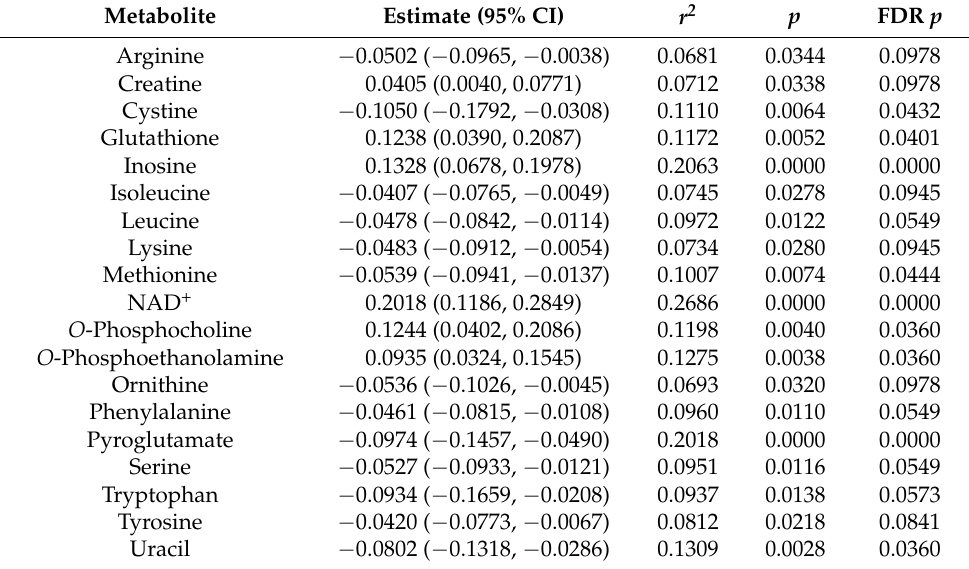
Table 3. Associations between placenta metabolites and birth year. In samples with a molar sum of urinary DEHP metabolites below the median ( n = 66), we conducted multiple linear regressions to measure the association between each log 10 -transformed placenta metabolite concentration and birth year after adjustment for gestational age at delivery, maternal metabolic condition, homeownership status, maternal race/ethnicity, and maternal education. We conducted permutation testing under the reduced model using 4999 permutations for each metabolite and corrected for false discovery rate (FDR). Only metabolites with FDR p -values < 0.1 are